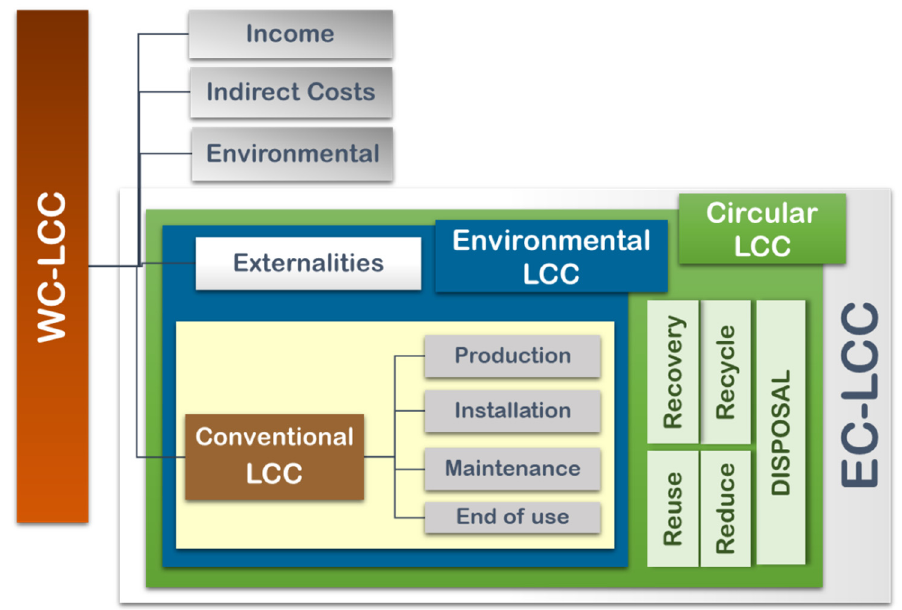
Figure 4. New economic approach, WEC-LCC elements (source: our elaboration).